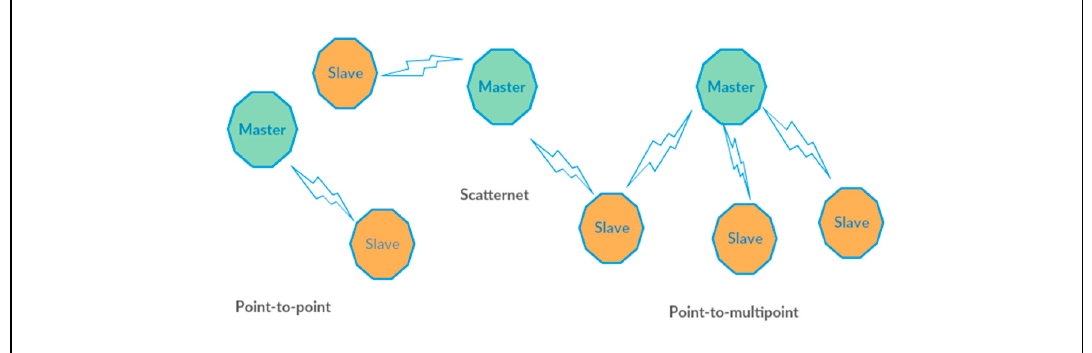
Figure 4. Bluetooth piconet configurations [1,7].